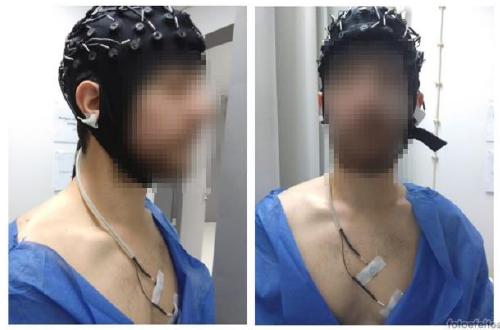
Figure 2. Equipment set-up used in the experiment.